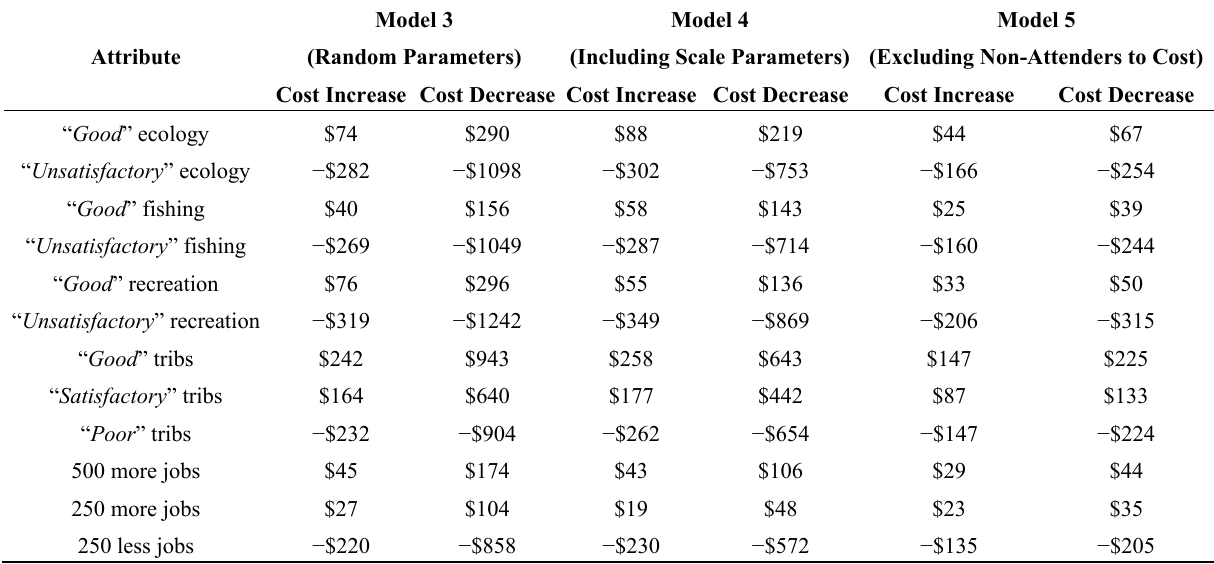
Table 5. Mean Marginal willing to pay (WTP) or willing to accept (WTA) under Cost Increase or Decrease